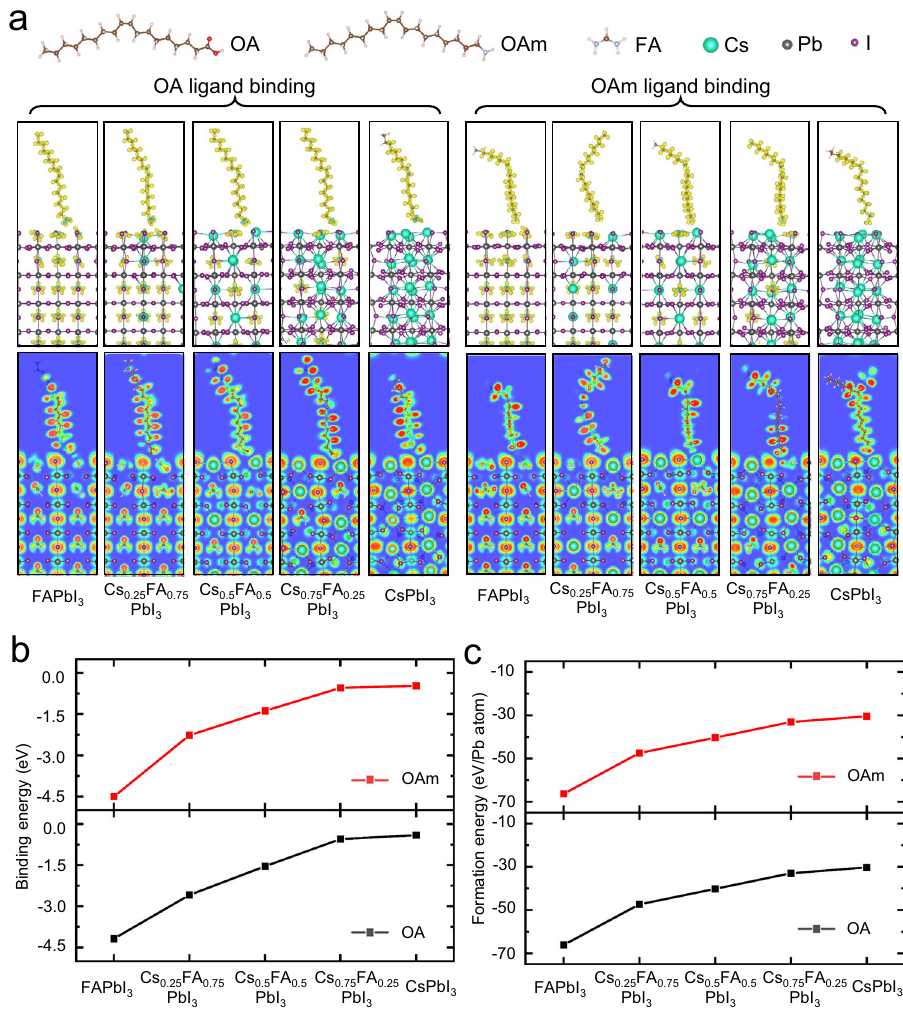
Fig. 4 | Ligand binding properties for Cs x FA 1-x PbI 3 PQDs of various composi- tions.a Charge density difference plots (upper) and electron localization function analyses (below) for one OA/OAm ligand adsorbed on the surface of Cs x FA 1-x PbI 3 PQDs. Red and green denotes areas of electron accumulation and depletion in